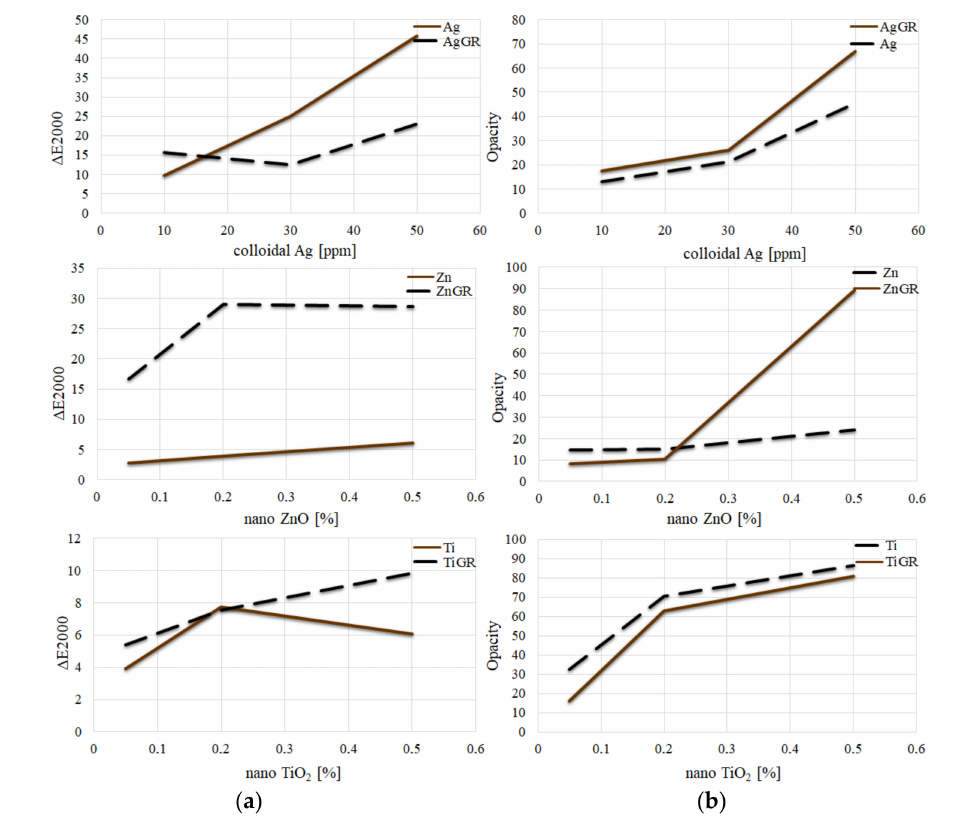
Figure 6. Evaluation of color properties of packaging: ( a ) A comparison of differences ( ∆ E) of the samples in individual groups from the control sample Ctrl/Ctrl_GR. ( b ) Comparison of sample opacity with individual